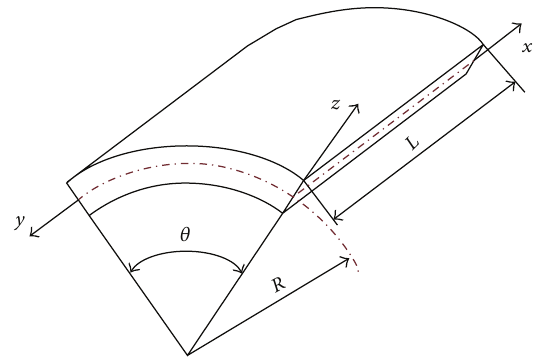
Figure 1: The model of an FGM cylindrical panel with simply supported edges and the coordinate